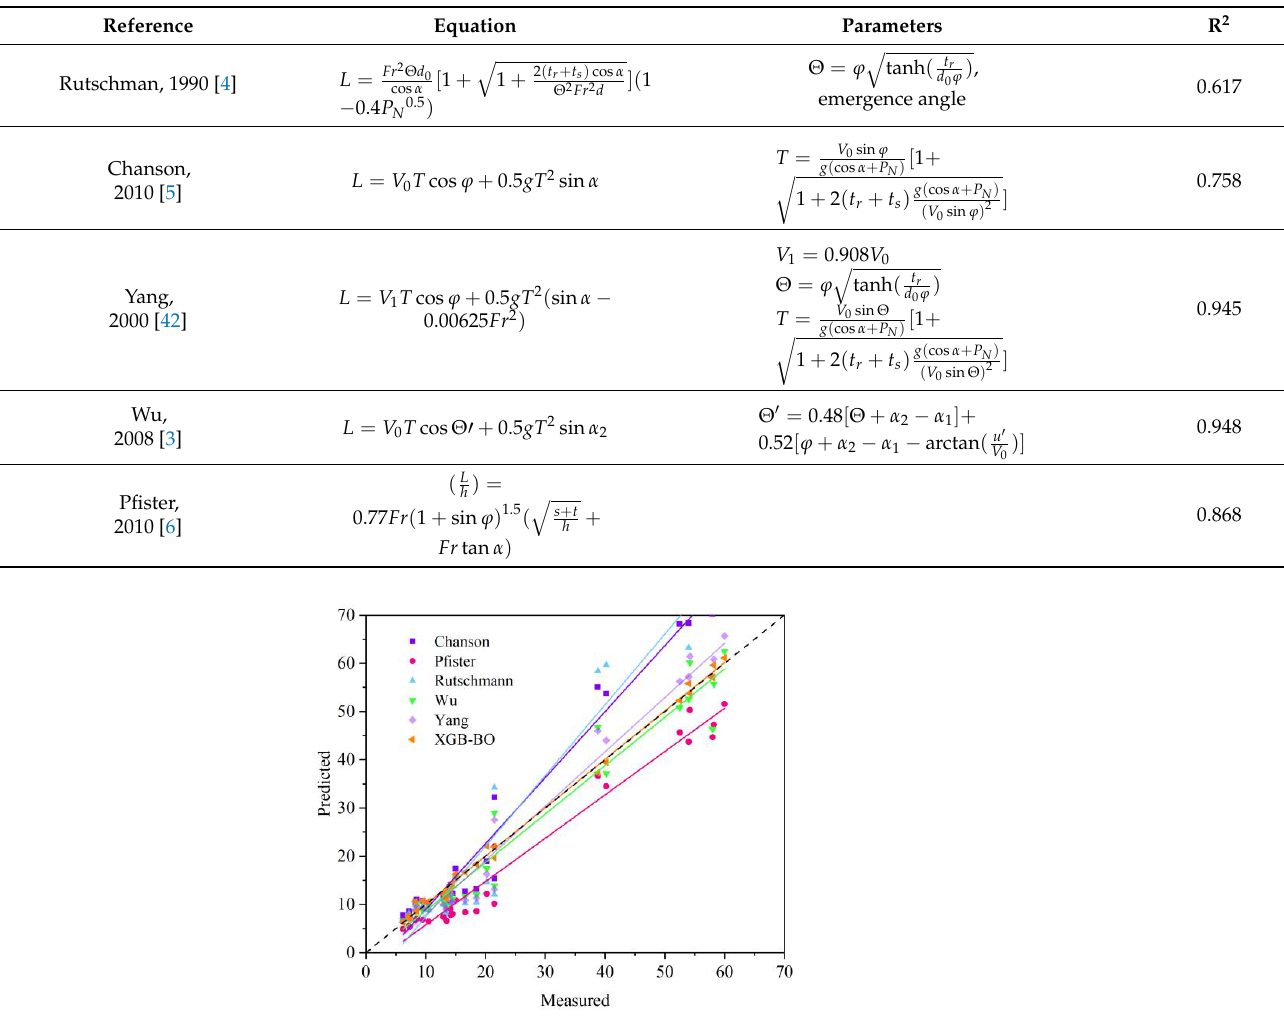
Table 5. Empirical correlations for cavity length prediction.